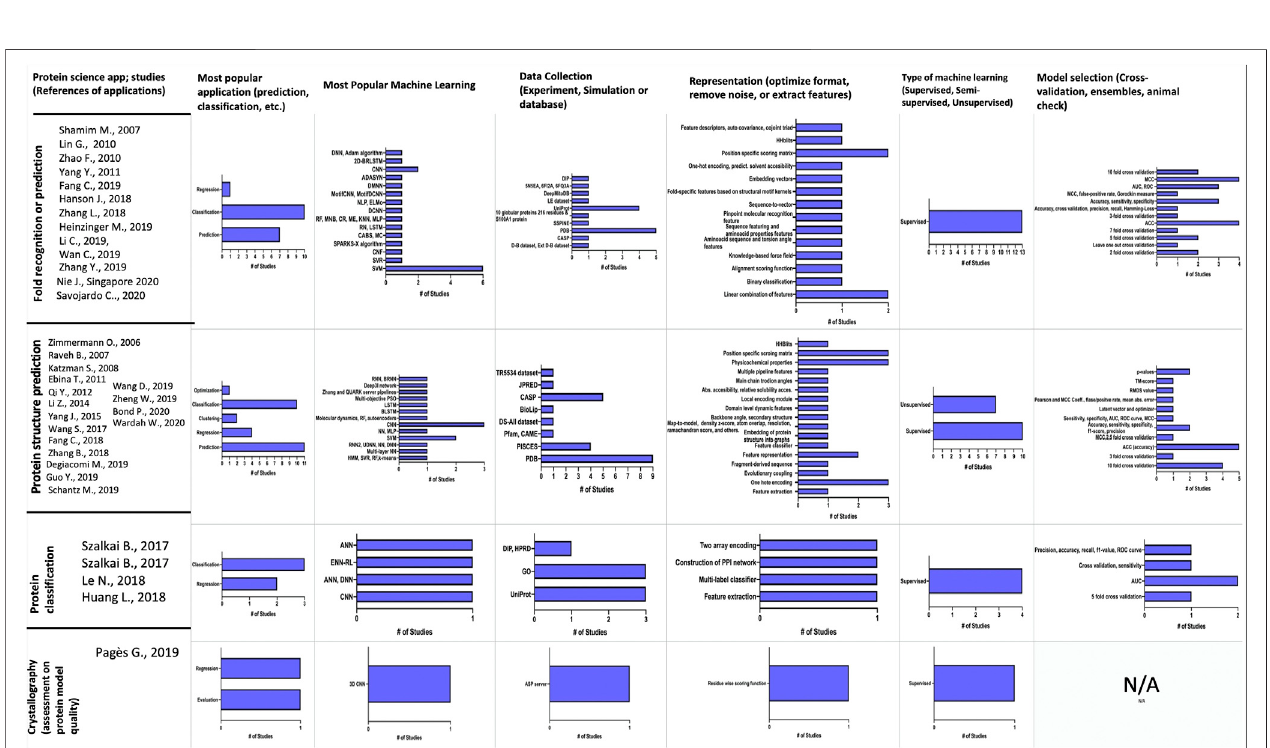
FIGURE 5 | Machine learning and arti fi cial intelligence applications to protein sciences. Information includes the number of studies, applications, databases, methods, and validation used.